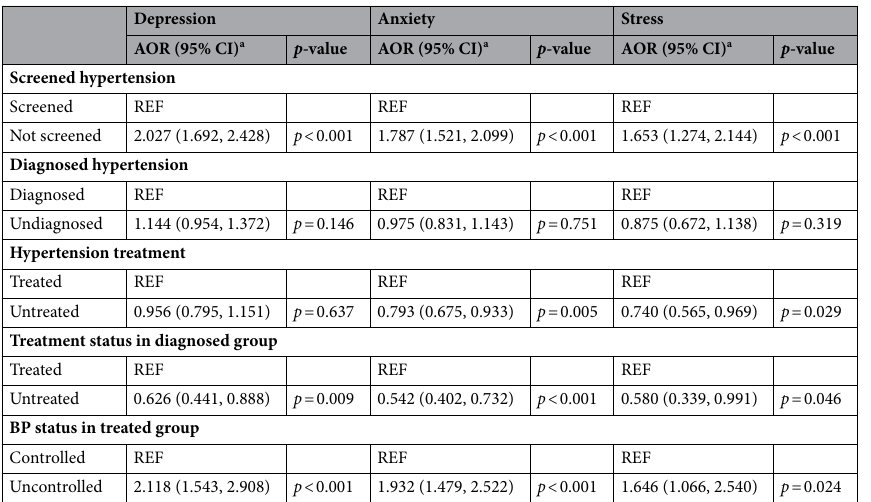
Table 8. The association between hypertension care status and depression, anxiety and stress (Multivariable logistic regressions). The adjusted odd ratios of depression, anxiety and stress (outcome variables) in binary logistic regression analysis with five hypertension care status each (independent variables). The result of AOR in this table were obtained from 15 models in total (5 different hypertension care cascade with 3 mental health indicators each), please find the results of binary logistic regression model for all included variables in Supplementary Tables S3–S7 (for different hypertension care status with three mental health indicators) with 2 the observed cases, χ , − 2 log likelihood, R 2 , and goodness-of-fit. AOR, adjusted odd ratios; BMI, Body Mass Index; CI, confidence interval; REF, reference. Values in parentheses are 95% of confidence interval. a Adjusted for age, sex, ethnicity, marital status, education, income, diabetes status and